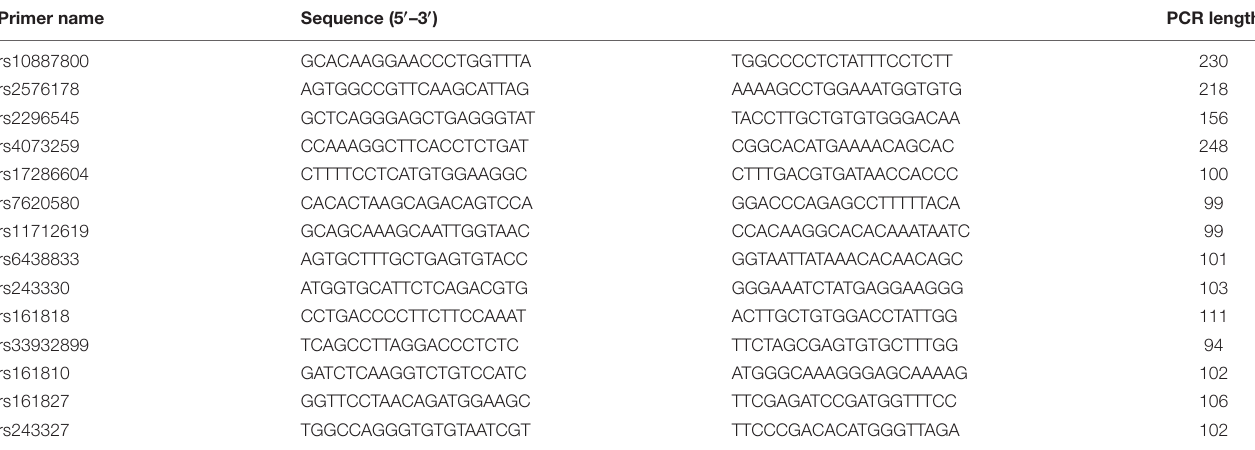
TABLE 1 | Primers of target genes used in the